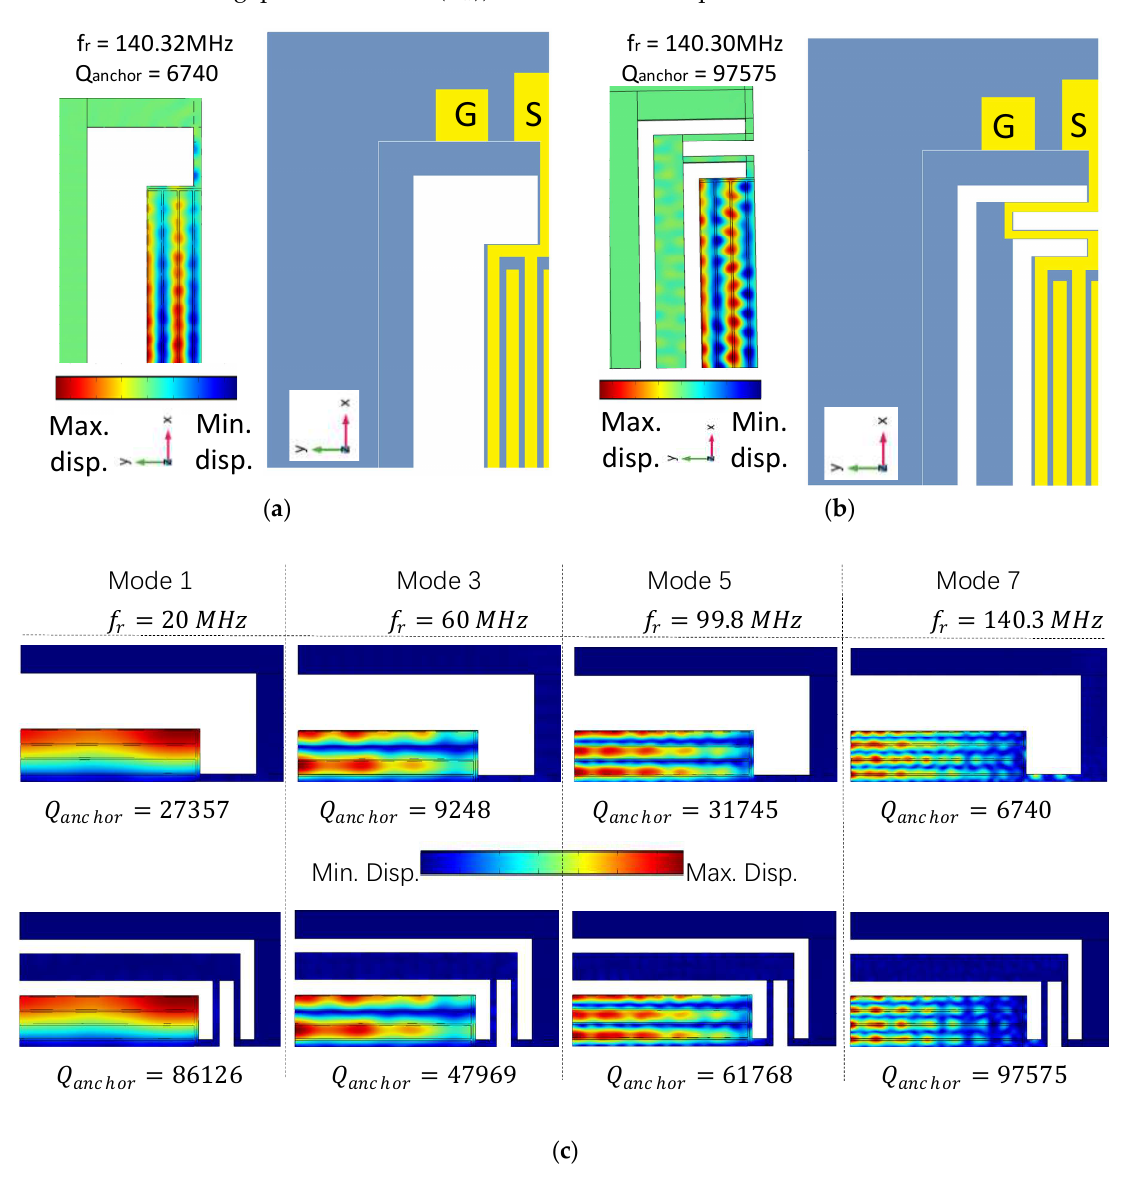
Figure 4. ( a ) Schematic top view along with the respective displacement profile (y-field) of the conventional resonator, ( b ) schematic top view along with the respective displacement profile (y-field) of the EPF resonator, and ( c ) FE simulated vibration modes (total displacement field) and their respective quality factors obtained using model analysis for conventional and EPF resonators in their fundamental (Mode 1), third-order overtone (Mode 3), fifth-order overtone (Mode 5), and seventh-order overtone (Mode 7) with a symmetric mode of vibration.